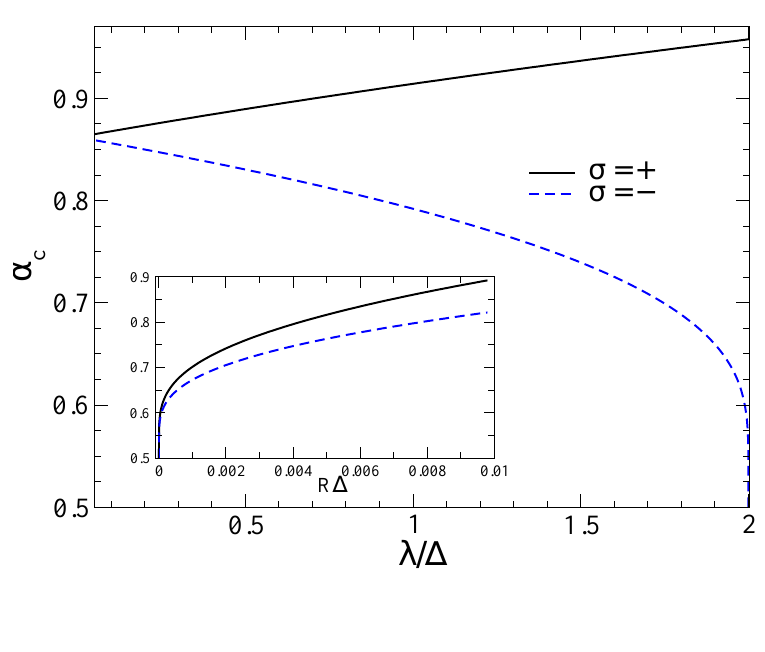
Figure 4. Main panel: Critical Coulomb impurity strength α R ∆ = 0 . 01 and the lowest ( j = 0 , σ = ± ) bound states. Inset: α for λ = 0 . 6∆